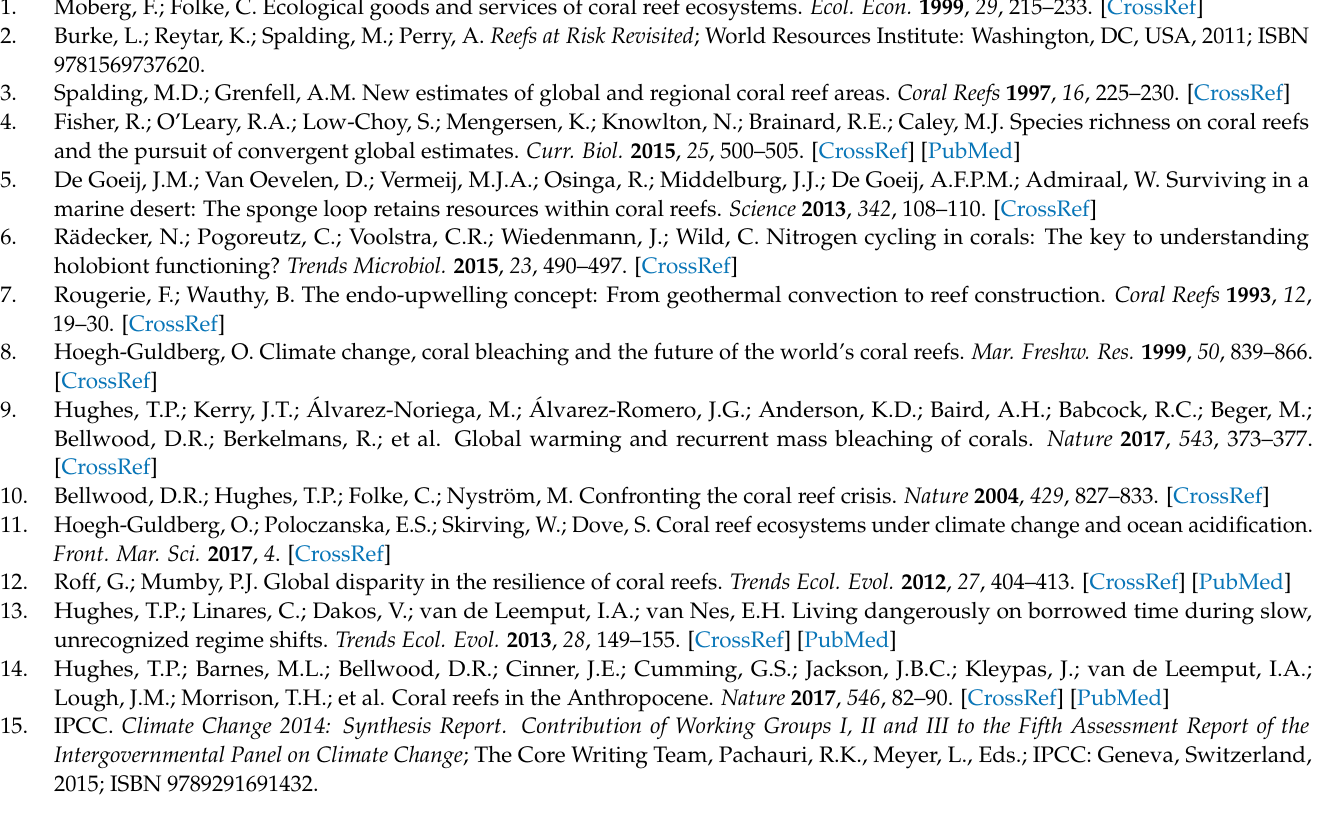
Table S27: Multiple comparisons for the recruit